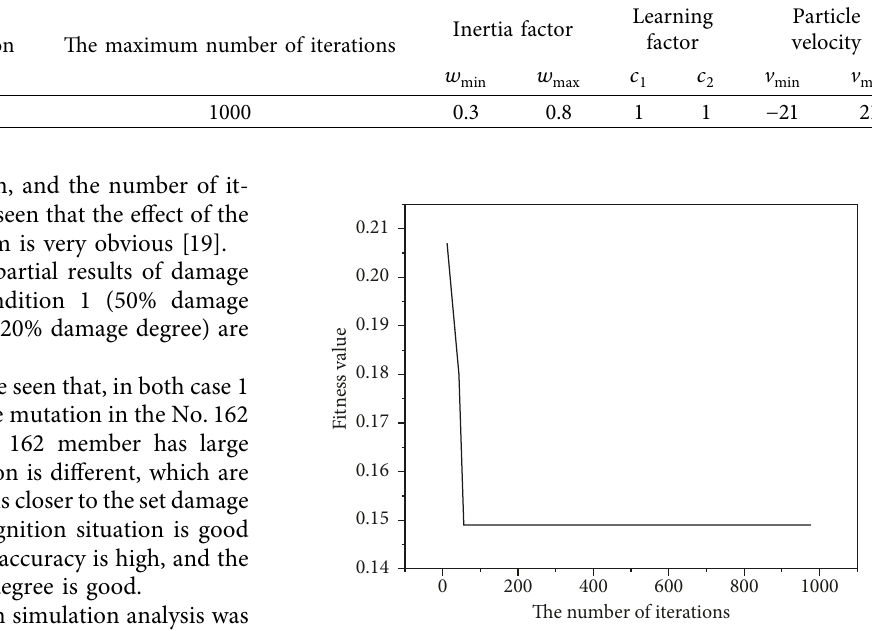
Figure 2: Flow chart of damage identification. Table 1: Particle swarm optimization parameter settings.